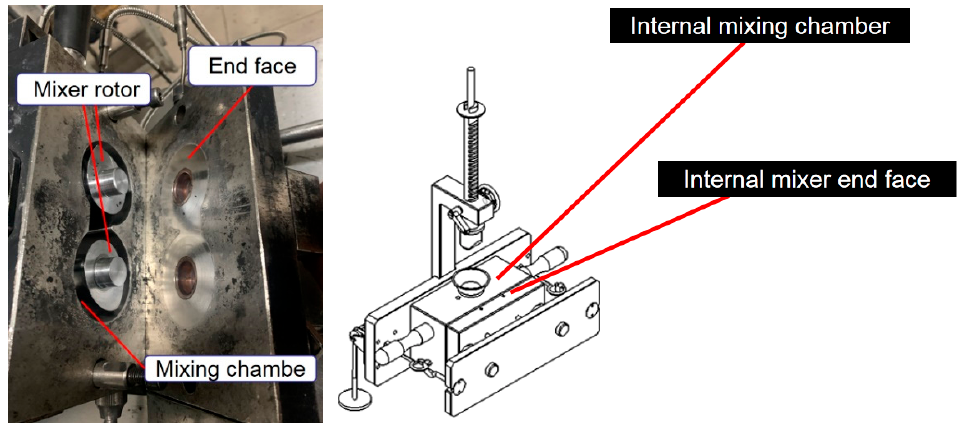
Figure 3. Hake internal mixer.